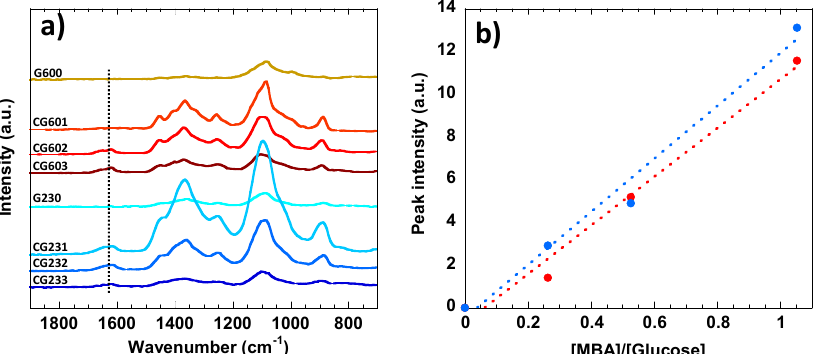
Polymers 2019 , 11 , x FOR PEER REVIEW In the full Raman spectra of the cellulose samples without MBA (G600 and G230), the specific bands at 1092 cm − 1 , 1362 cm − 1 and 2887 cm − 1 , which can be assigned to asymmetric and symmetric C- O-C stretching, C-H 2 bending and C-H stretching, respectively, could be identified (data not shown) Figure 3. FTIR spectra of ( a ) 2 wt% cellulose samples, and ( b ) the linear regression analysis between Figure 3. FTIR spectra of ( a ) 2 wt% cellulose samples, and ( b ) the linear regression analysis between [73,74]. The zoomed Raman spectra between 700 cm − 1 and 1900 cm − 1 are presented in Figure 4a. A the peak intensities of the carbonyl group at 1656 cm − 1 and the MBA / glucose molar ratios. The vertical the peak intensities of the carbonyl group at 1656 cm − 1 and the MBA/glucose molar ratios. The vertical characteristic band for cross-linked cellulose was detected at 1621 cm − 1 and assigned to the -C=O dashed lines at 1656 cm − 1 , 1621 cm − 1 and 1540 cm − 1 can be assigned to the -C = O, C = C and -NH dashed lines at 1656 cm − 1 , 1621 cm − 1 and 1540 cm − 1 can be assigned to the -C=O, C=C and -NH vibration vibration mode from the MBA [70,71]. The enhanced band intensity with MBA concentration was vibration modes of MBA, respectively. The peak intensities of the -C = O group at 1656 cm − 1 have been modes of MBA, respectively. The peak intensities of the -C=O group at 1656 cm − 1 have been found to be in perfect agreement with the previously discussed FTIR data. The regression analysis of normalized with respect to the intensities of the common peaks at 1100 cm − 1 and 4000 cm − 1 . The linear normalized with respect to the intensities of the common peaks at 1100 cm − 1 and 4000 cm − 1 . The linear the Raman data was also conducted and compared with the FTIR data (Figure 4b). Likewise, the regressions show coe ffi cients of determination “R” of 0.95 and 0.99 for the hydrogels cured at 60 ◦ C regressions show coefficients of determination “R” of 0.95 and 0.99 for the hydrogels cured at 60 °C grafting of the -C=O onto the cellulose matrix perfectly correlates with the MBA concentration. (red) and 23 ◦ C (blue), respectively. (red) and 23 °C (blue), respectively.